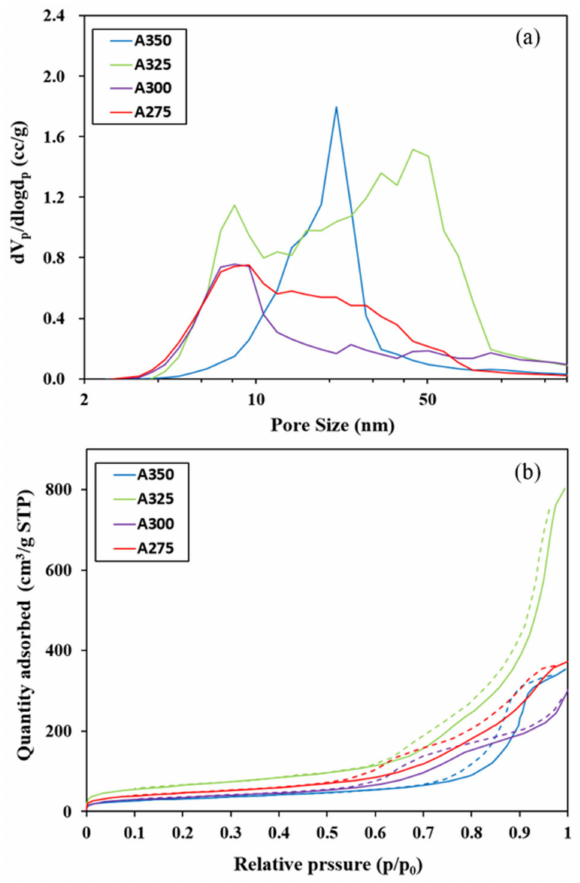
Figure 4. ( a ) Pore size distribution profiles; ( b ) N 2 adsorption-desorption isotherms of the alumina catalysts A275, A300, A325, and